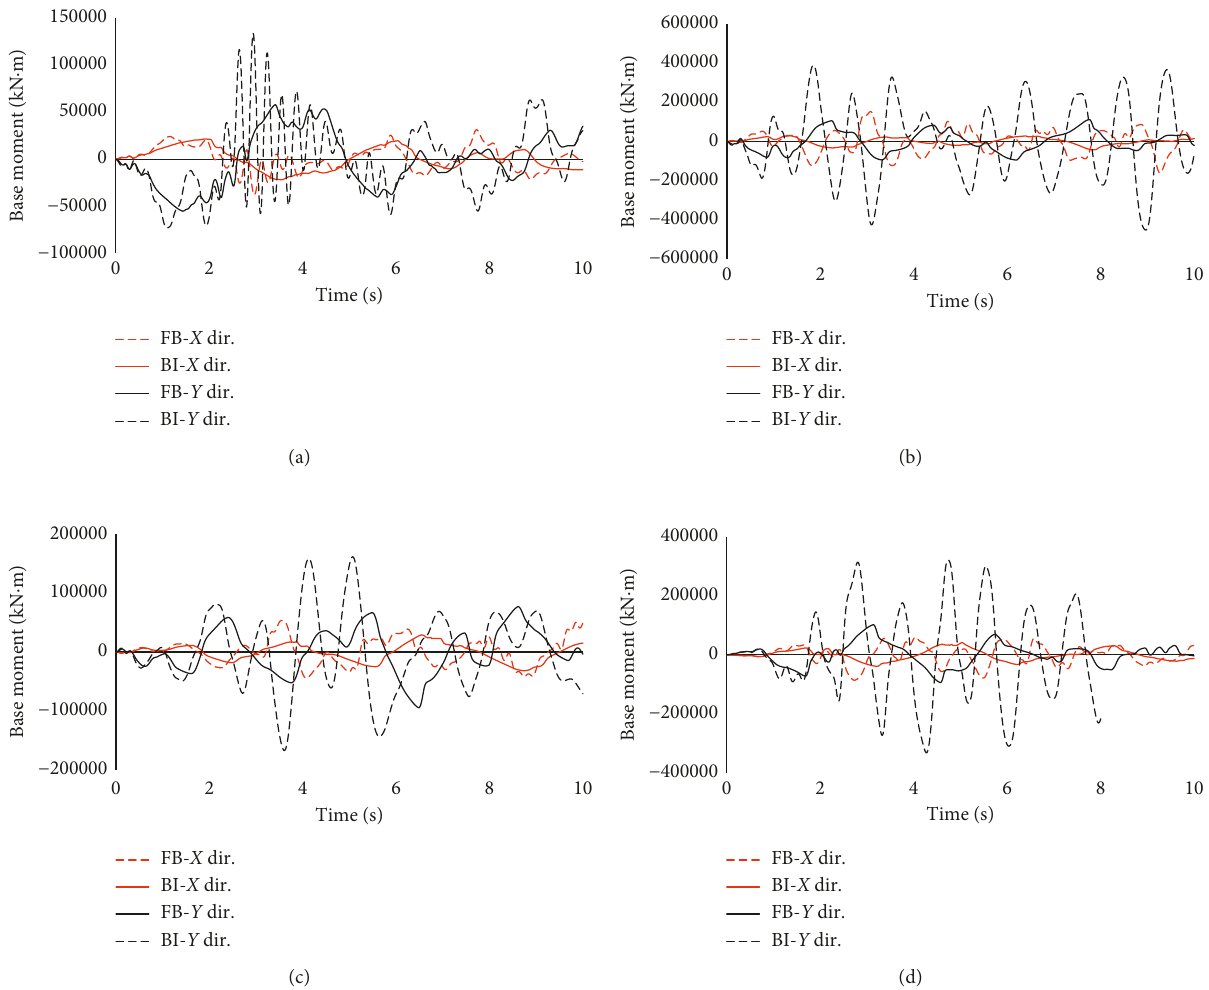
Figure 15: Base moment for FFB and FBI adjacent buildings under applied earthquakes. (a) Cape. (b) LACC-N. (c) S-Monica. (d)